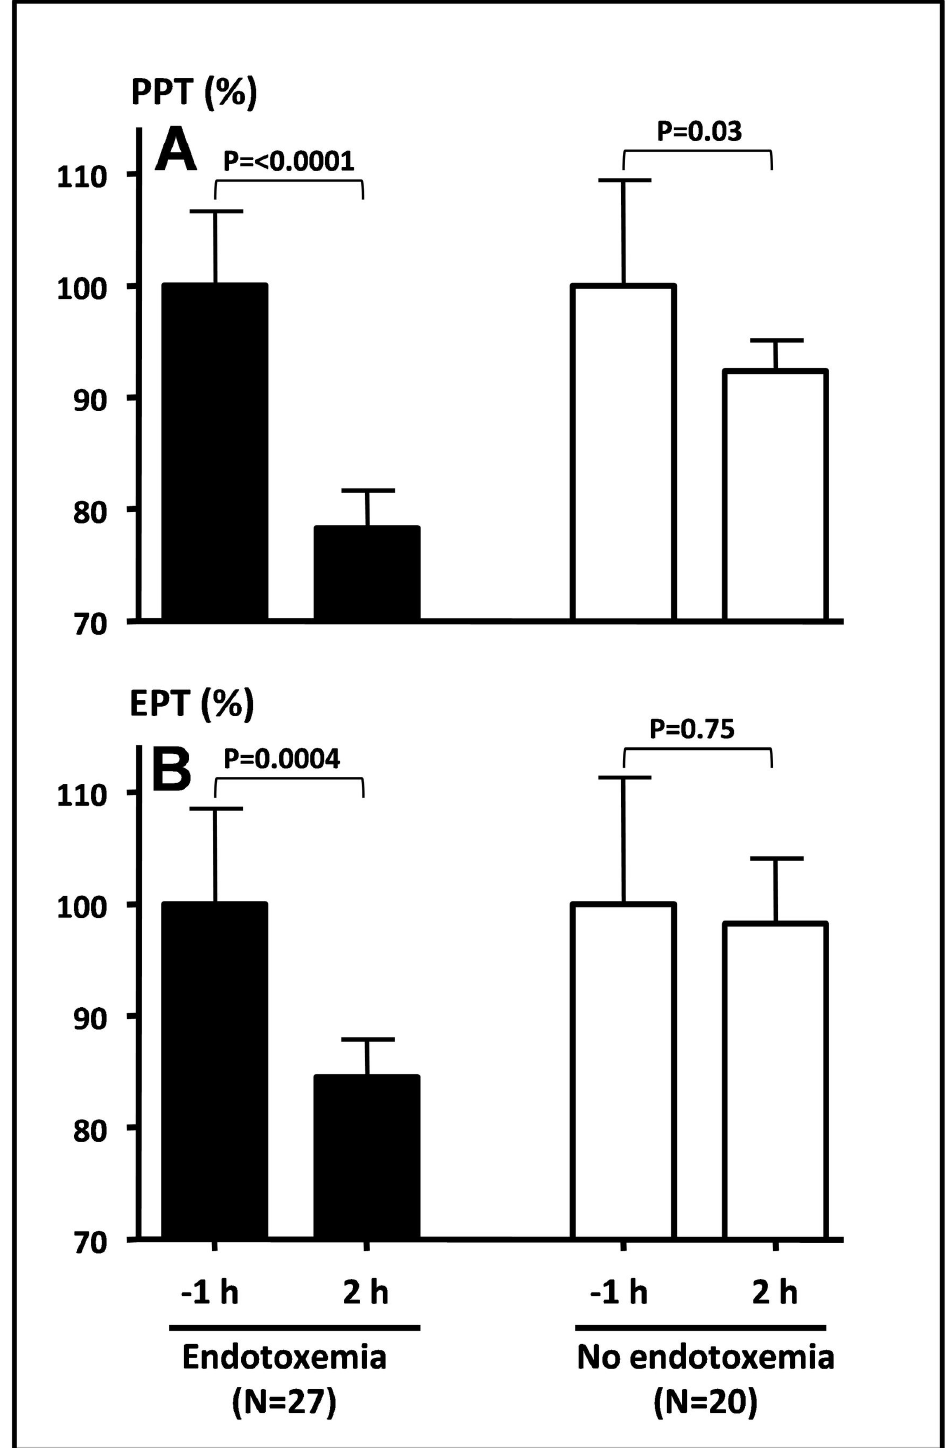
Figure 2. Relative change in pain thresholds during human endotoxemia. A: combined pain pressure threshold (PPT) and B: combined electrical pain threshold (EPT) measured 2 hours after endotoxin administration. Values are depicted as percentage change from baseline (-1 h), where baseline was set at 100%. White bars: control subjects, black bars: endotoxin treated subjects. Data expressed as mean±SEM. h: hours. doi: 10.1371/journal.pone.0084159.g002 PLOS ONE |